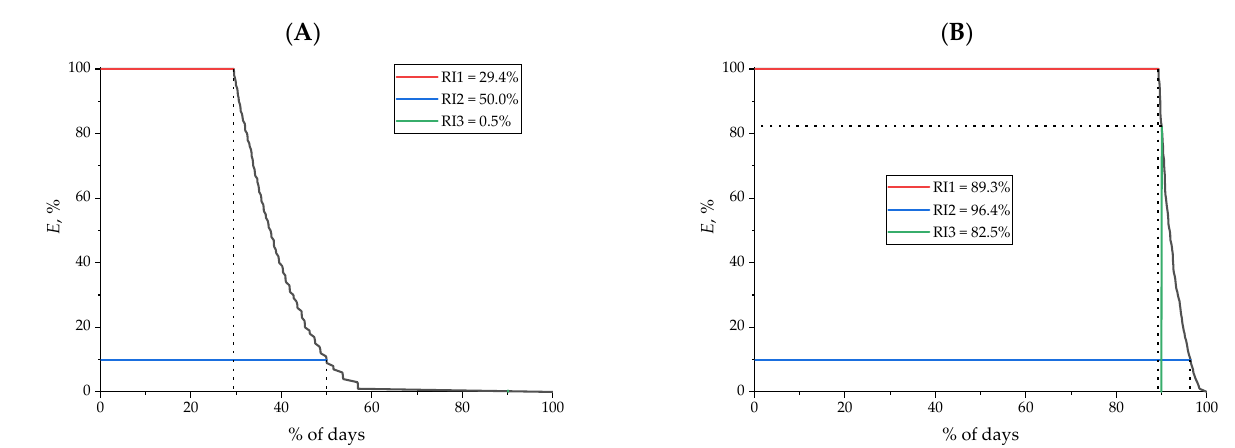
Figure 5. The efficiency curve for a simulation of a separate RWH system ( A ), and a combined system ( B ). As can be seen, the RWH system could only assure total water demand coverage for 29.4% of the days of the analyzed period (RI1, Figure 5A). It could be increased about three times when combining it with water recovery from the exhaust air system (RI1, Figure 5B). The tank supplied a minimum of 10% of the water demand for 50% of